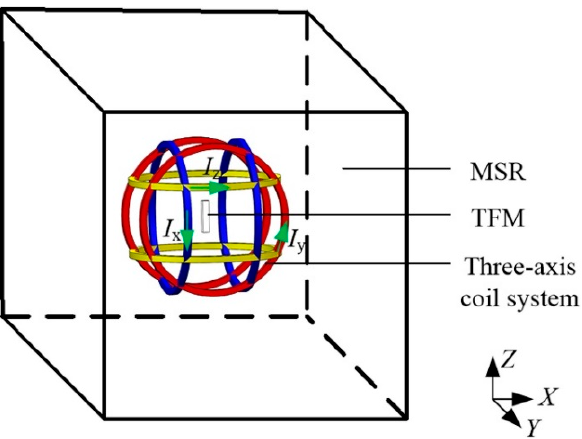
Figure 6. Schematic diagram of the calibration method of TFMs based on MSR and TUMC.